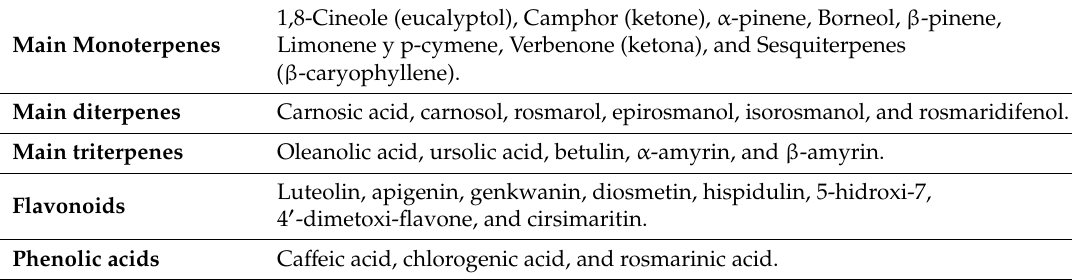
Table 1. Main bioactive molecules in